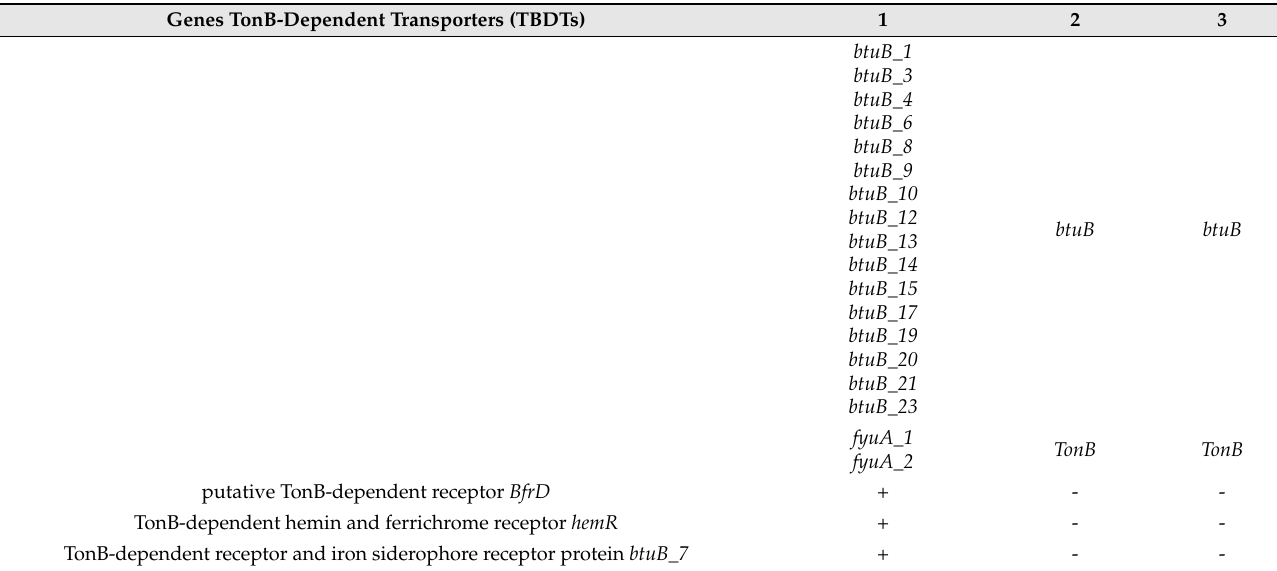
Table 8. Distribution of genes involved in TonB-dependent transporters (TBDTs) in 1, Pacificimonas pallium WHA3 T ; 2, Pacificimonas flava DSM 107612 T ; 3, Pacificimonas aurantium DSM 107782 T genomes using https://narrative.kbase.us/ accessed on 24 February